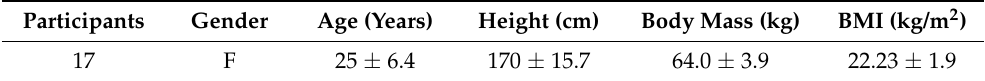
Table 1. Basic characteristics of the